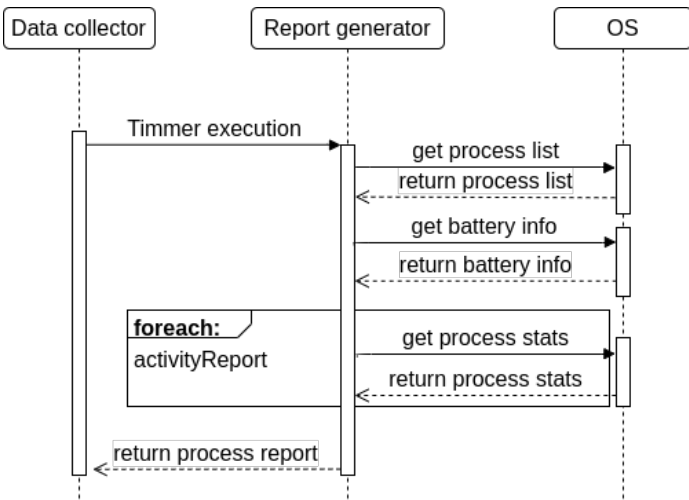
Figure 5. Collecting processes’ device data sequence